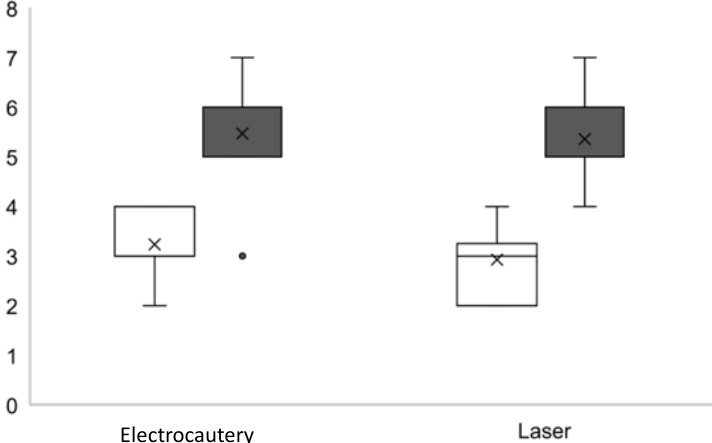
Figure 2. Assessment of ankyloglossia based on Bristol protocol (researcher 1). White = Before. Black = After.